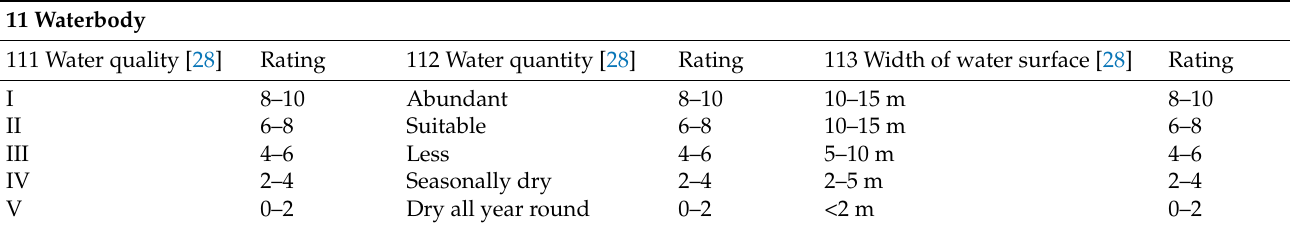
Table 6. Rating for elements of waterbody layer in ecological